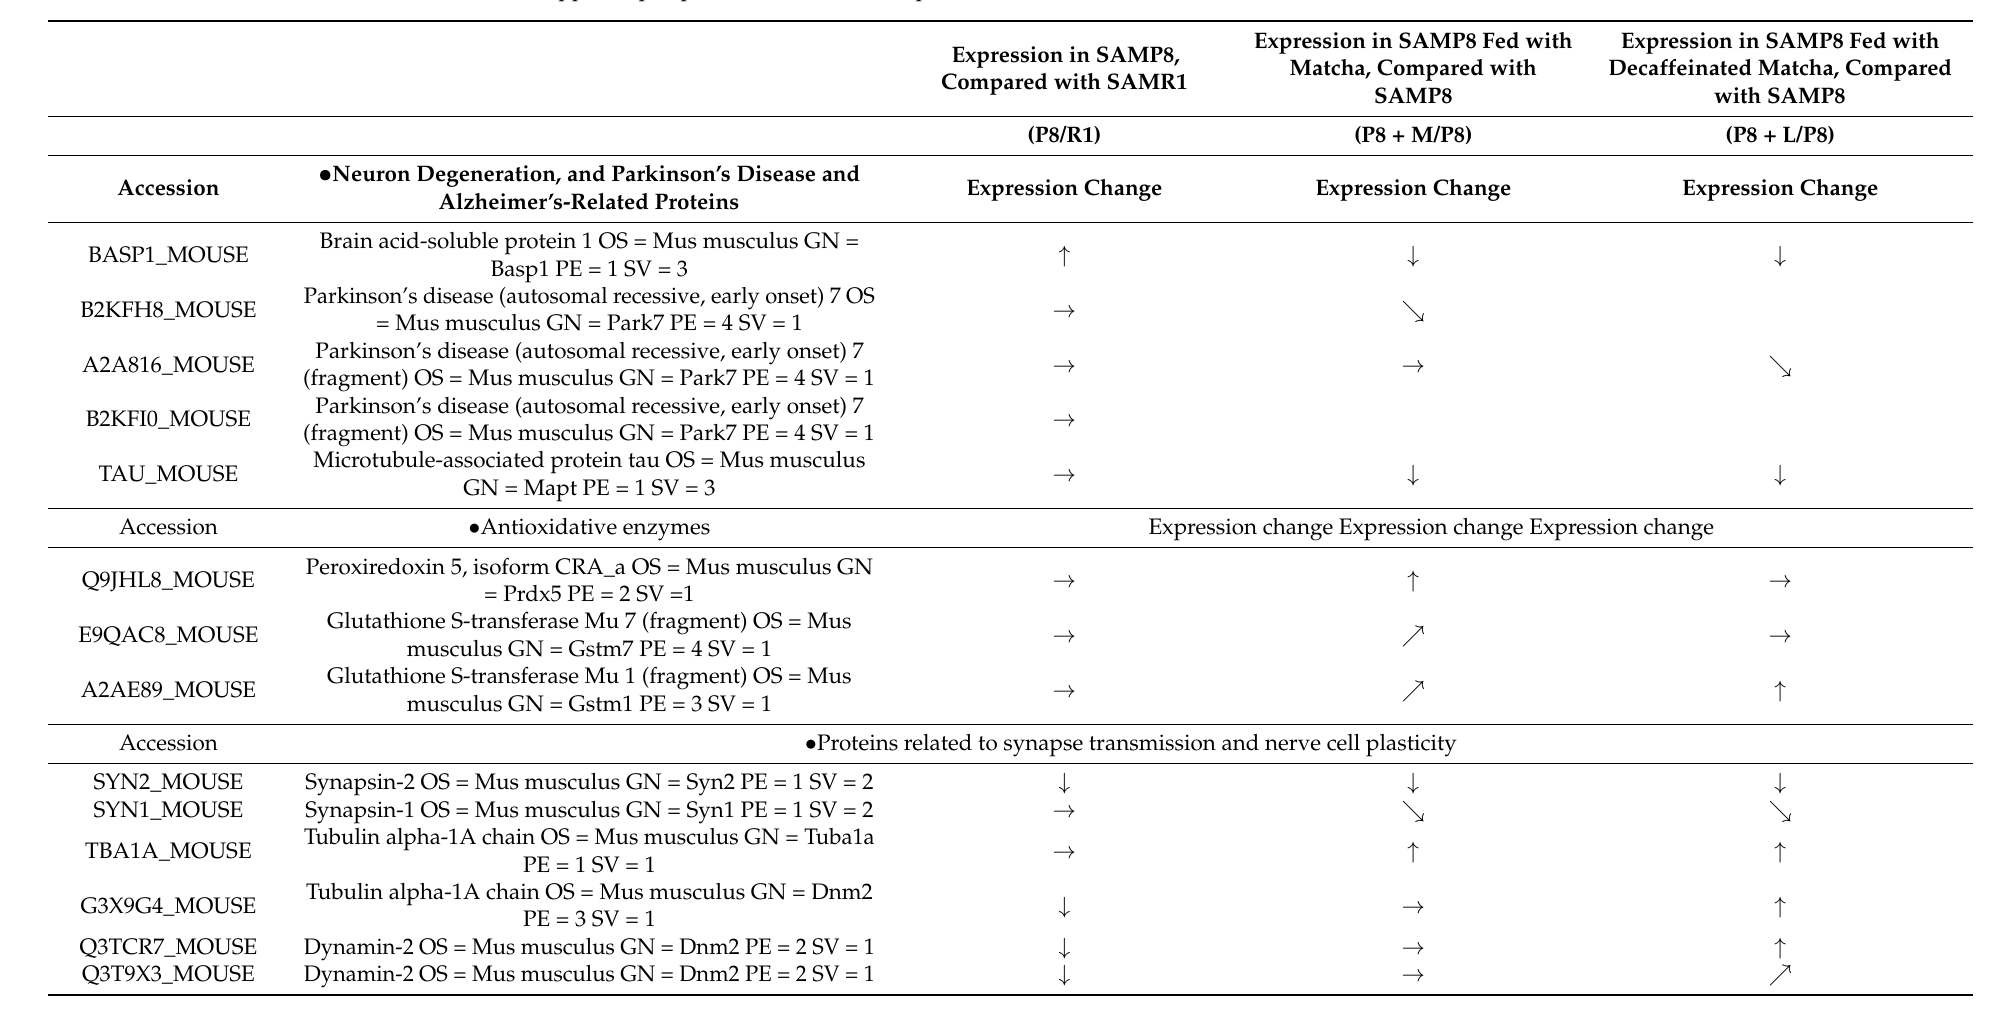
Table 7. Altered hippocampus proteins in SAMP8 compared with SAMR1 and the effects of matcha and decaffeinated matcha.